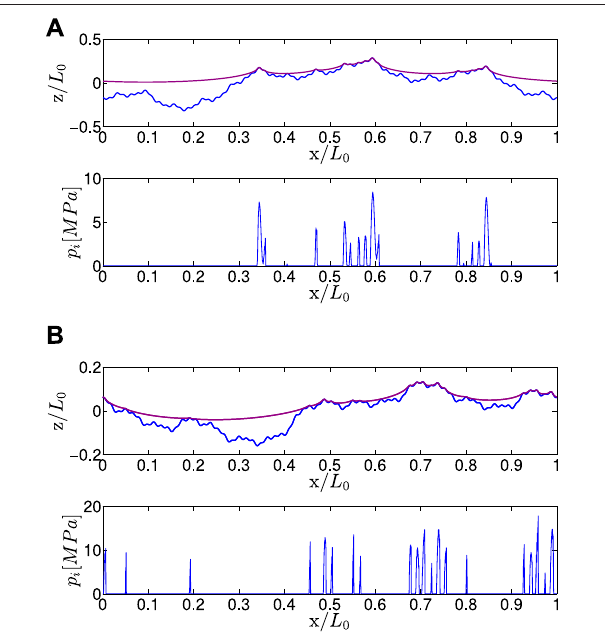
FIGURE 8 | Contact pressure distribution resulting from the repulsive law as a function of the dimensioness contact position for a sliding velocity